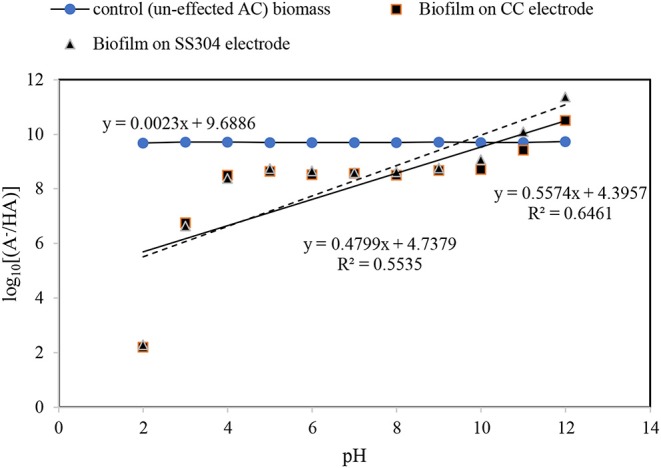
Henderson-Hasselbalch plots for the KNO3 and pH effect in de-attached biofilm.